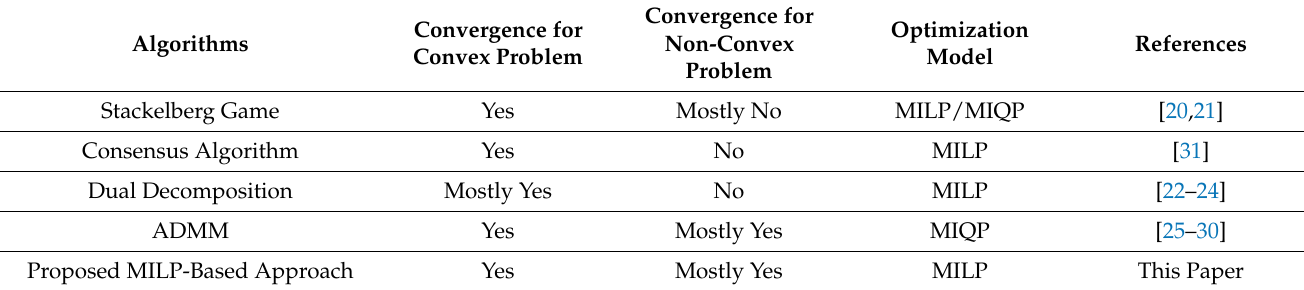
Table 1. Comparison of distributed energy management for networked